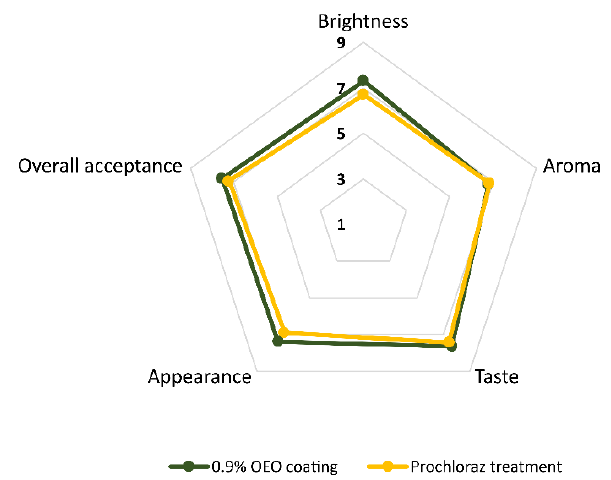
Figure 5. Sensory scores for mango samples treated with 0.9% OEO coating and Prochloraz fungi-